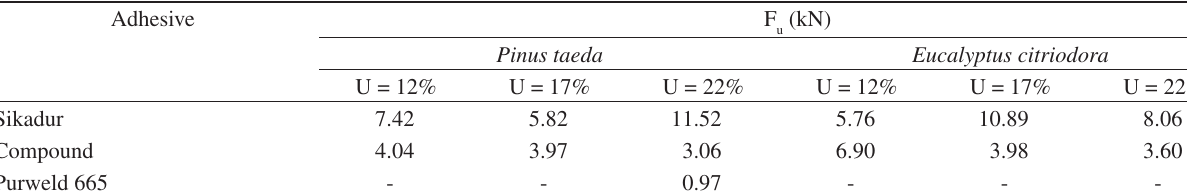
Table 4. Ultimate strength of the connection in the specimens – Static tests.